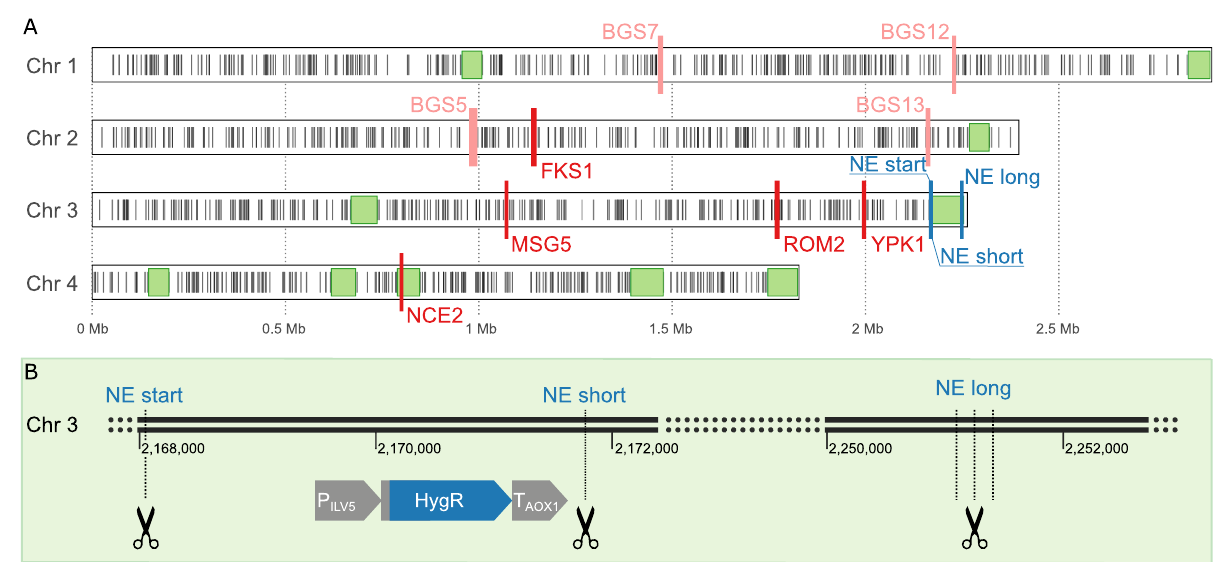
Figure 1. ( A ) Overview of all CRISPR targets and identified non-essential regions. Putatively non- essential (NE) regions with longer more than 50 kbp are shown as light green rectangles, while essential genes are depicted as black bars. The CRISPR targets for strain BSYBG10_chr3ne_HygR are shown in dark blue bars. Potential secretion-relevant targets for strain BSYBG10_3S1K_CalB based on homology to described effects in S. cerevisiae are shown in red and targets for strain UPP- C are shown in light red. ( B ) Detailed view of the 3 (cid:48) end of chromosome 3 of strain K. phaffii BSYBG10_chr3ne_HygR, showing the location of the Hygromycin resistance expression cassette at the 5 (cid:48) end of the NE region and the CRISPR targets aimed to remove the Hygromycin resistance cassette only (NE start–NE short) or the whole NE region (NE start–NE